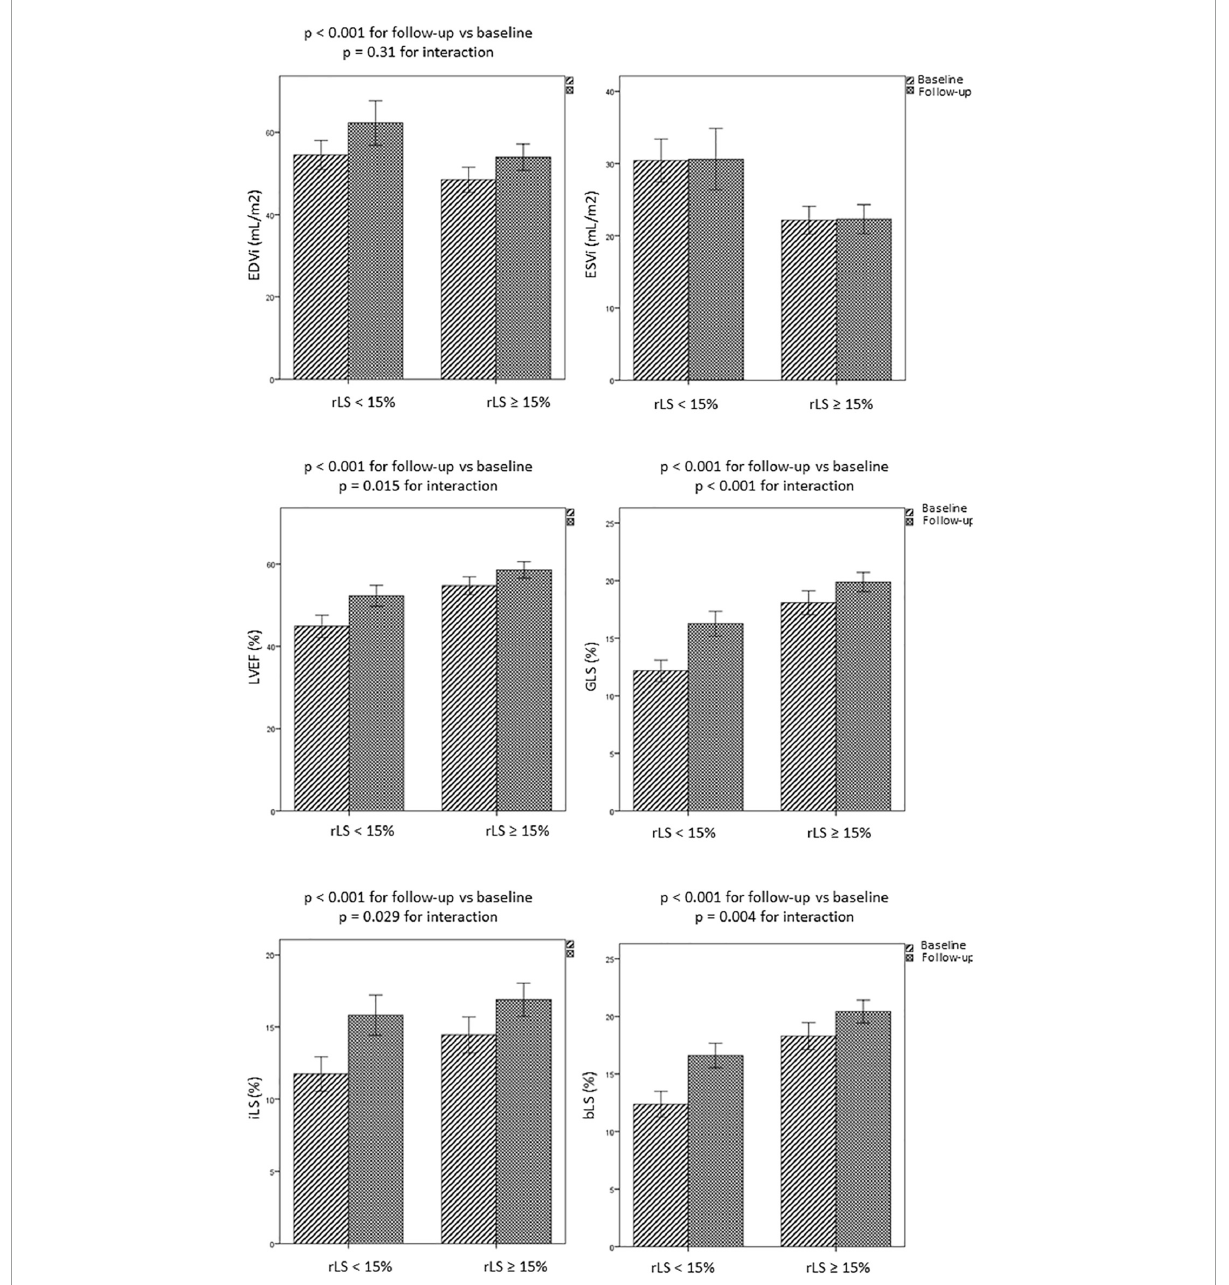
FIGURE5 Evolution over time of LV volumes and regional and global LV function in patients with rLS < 15% and ≥ 15% at baseline. bLS and iLS, border and infarct longitudinal strain; EDVi and ESVi, end-diastolic and end-systolic volumes indexed for body surface area; GLS, global longitudinal strain; LVEF, left ventricular ejection